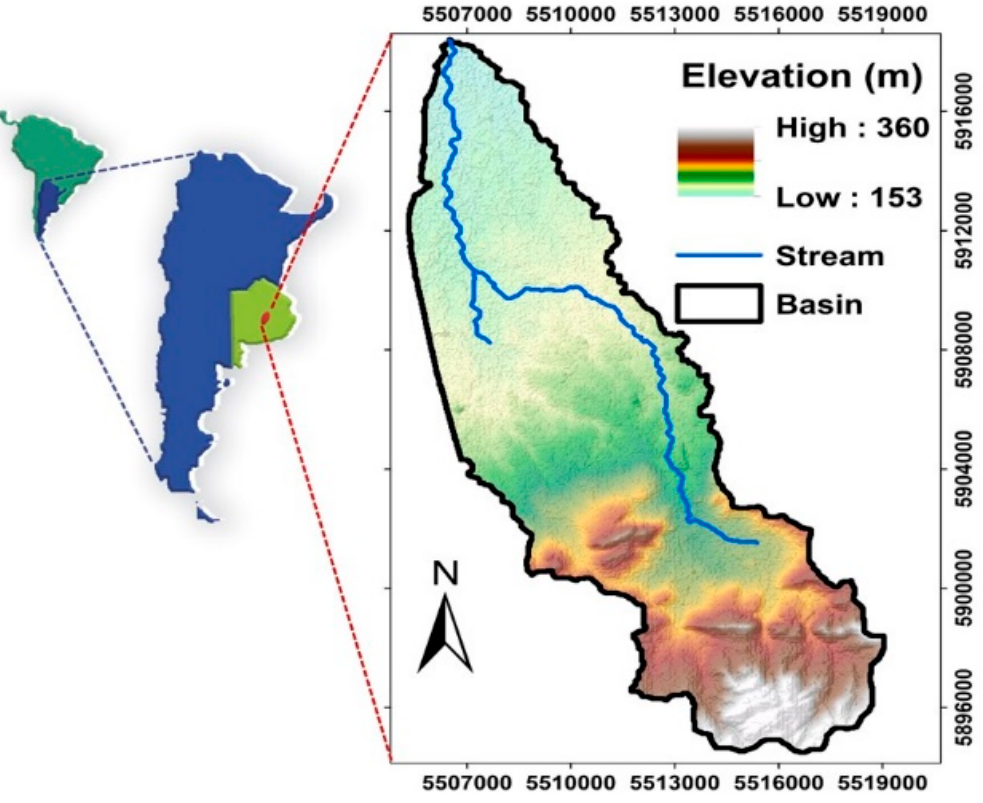
Figure 1. Study area: Santa Catalina stream basin.